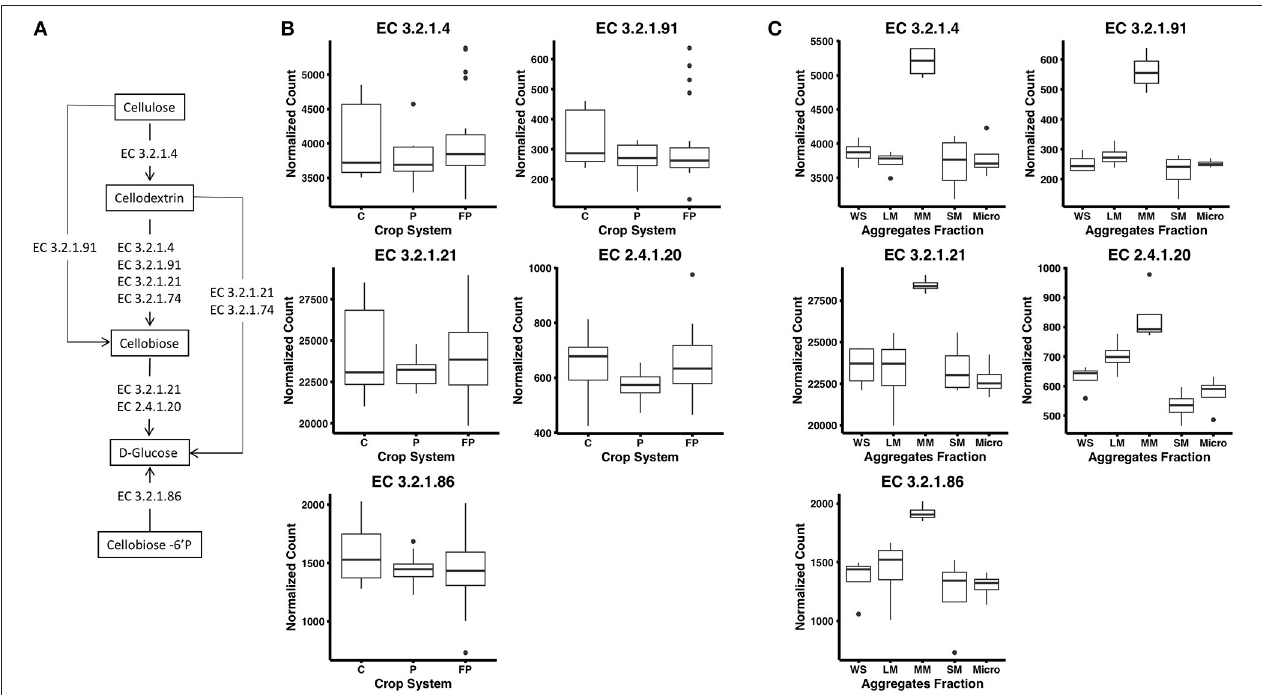
FIGURE 1 | (A) Cellulose decomposition enzymes from the KEGG database. Breaking down cellulose microfibrils requires endoglucanases that randomly attack the cellulose chain (EC 3.2.1.4) and exoglucanases including cellodextrinases (EC 3.2.1.74) that cleave from the end of the cellulose chains releasing cellobiose. Cellobiohydrolases (EC 3.2.1.91) are endoglucanases that can degrade cellulose or cellodextrin to cellobiose. Finally, β -glucosidases (EC 3.2.1.21) cellobiose phosphorylase (2.4.1.20) and 6-phospho- β -glucosidase (EC 3.2.1.86) release glucose from cellobiose and other soluble cellodextrins. (B) Abundance of reads encoding for KEGG enzymes in corn (C), unfertilized prairie (P), and fertilized prairie (FP) metagenomes. (C) Abundance of reads encoding for KEGG enzymes in aggregates from fertilized prairie (FP) metagenomes. WS, whole soil; LM, large; MM, medium; SM, small; Micro, micro aggregates. Normalized counts estimated with DeSeq2